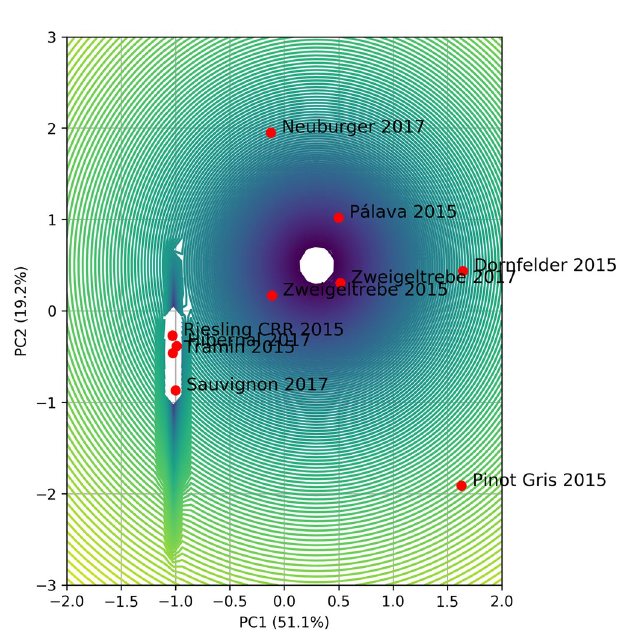
Figure 3. GMM for standardized 2PCs in analysis for fatty acid